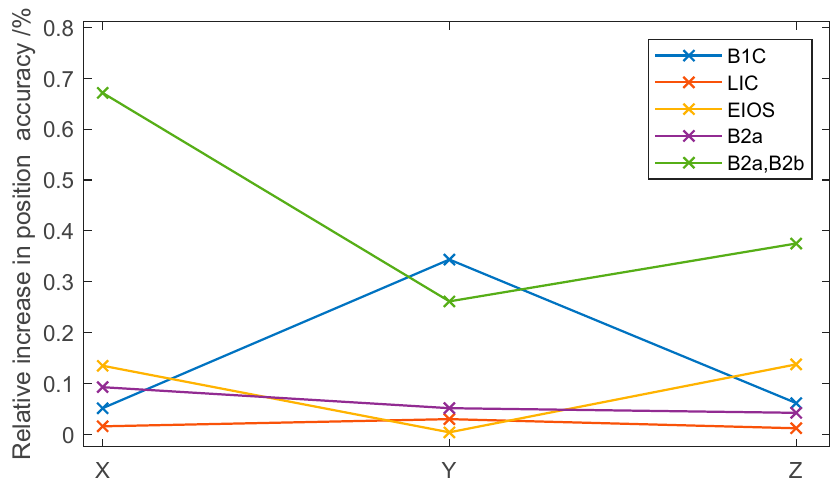
Figure 24. Relative increase in position accuracy.